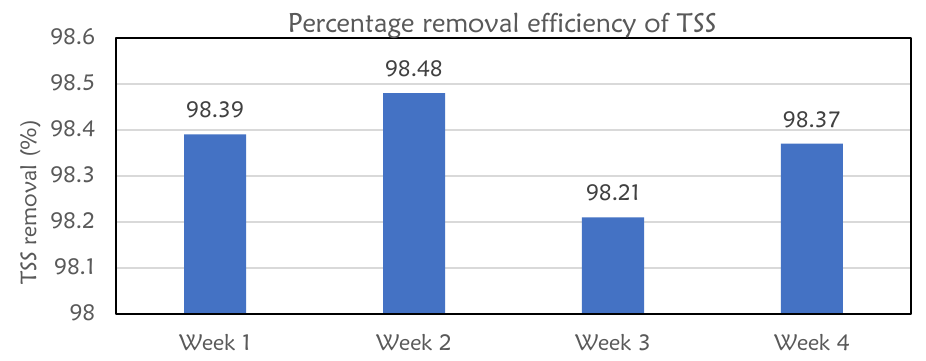
Figure 5: Percentage removal efficiency of TSS analysis of 4 weeks.